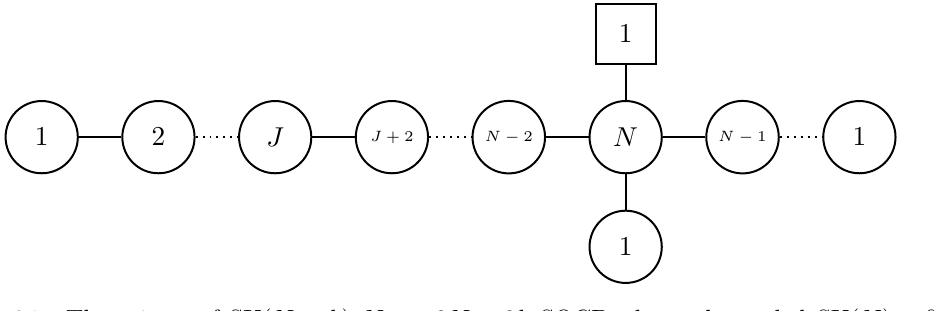
Figure 21 . The mirror of SU( N − k ) N f = 2 N − 2 k SQCD plus a decoupled SU( N ) × SU( k ) bifundamental.